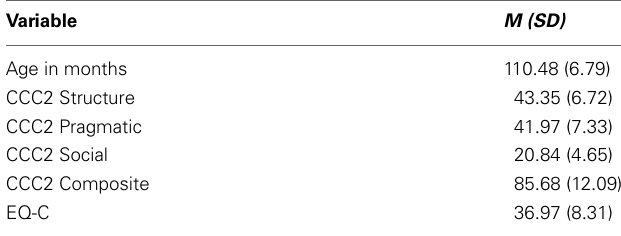
Table 1 | Participant